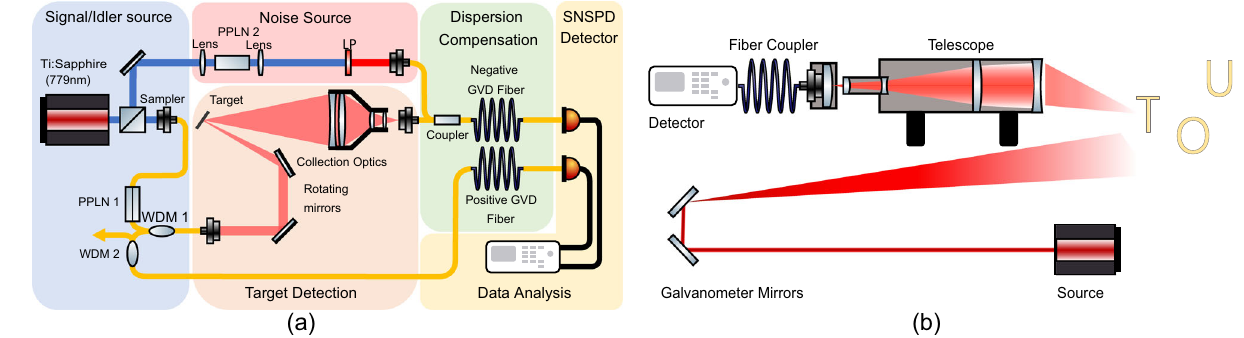
Fig. 2 | Experiment and collection telescope design. a Experimental schematic for the DNCTD protocol including scanning and collection optics. Relevent abbri- vations: Periodically poled lithium niobate (PPLN), Group-velocity